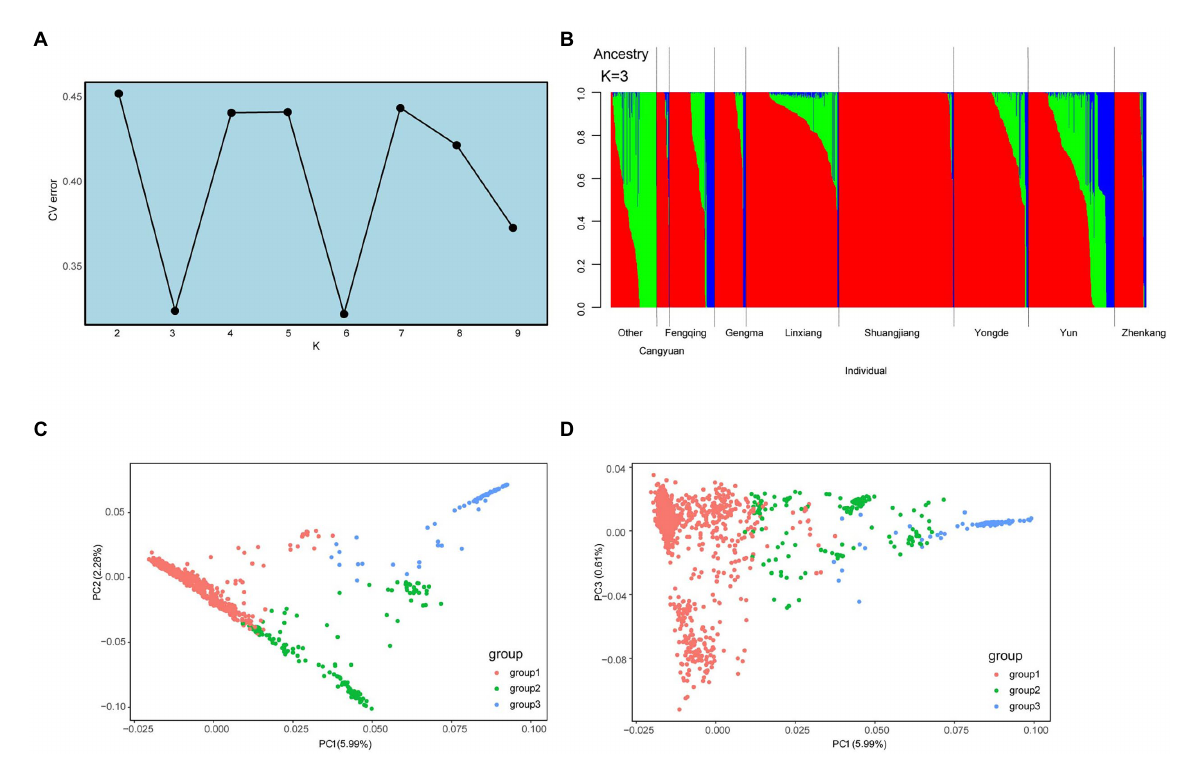
FIGURE 2 (A) Cross-validation errors. The x-axis represents the K value, while y-axis indicates the cross-validation errors. The dot shows K = 3 with the lowest cross-validation errors. (B) Population structure of the tea plant collections, which represents the best inferred K-value with the lowest cross- validation errors. (C,D) PCA analysis. From left to right, the three squares indicate group I, group II, and group